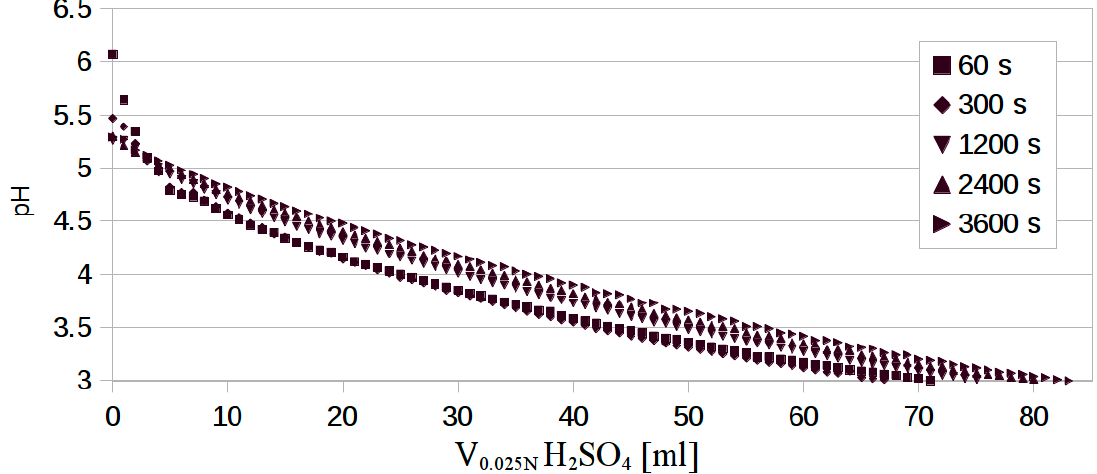
Figure 2. Pine chip suspension titration curves. Different initial latency times render a different system response. The curves can be assumed as linear under the boundary of pH 4.